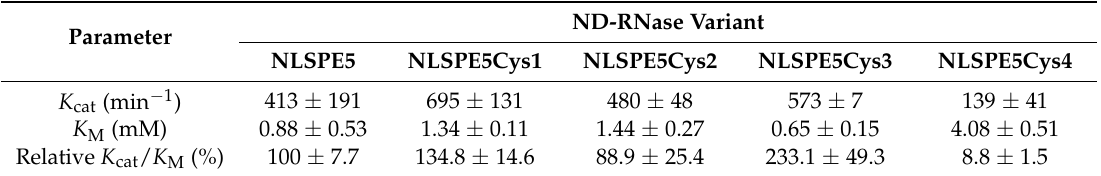
Table 3. Catalytic parameters for the hydrolysis of C>p of the different ND-RNase variants.